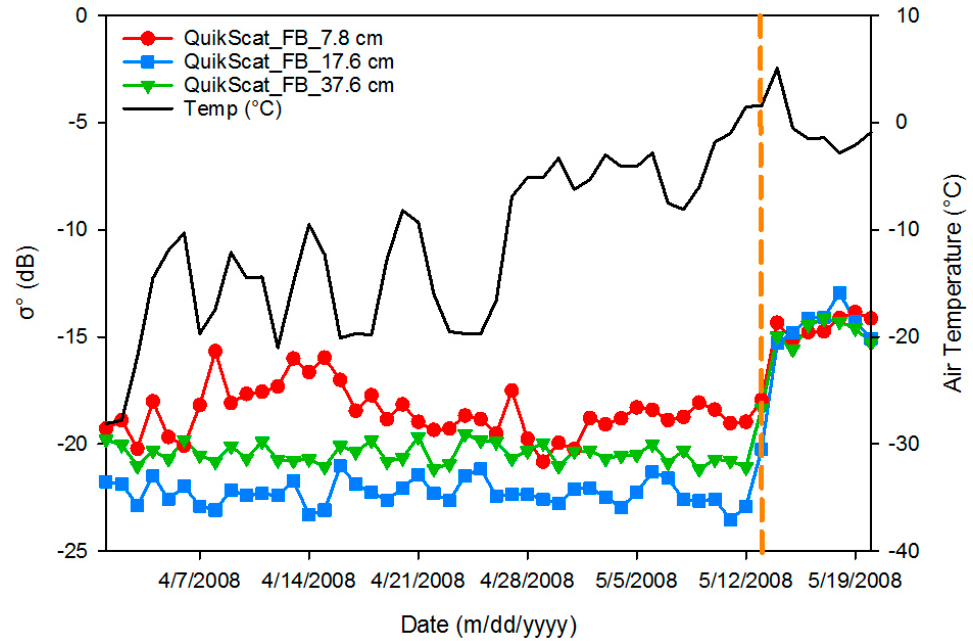
Figure 4. Time series evolution of daily mean air temperature and QuikSCAT σ ° for the Franklin Bay (FB) snow thickness sites between April 1 and May 20, 2008 (during the winter season). The upturn in σ ° at melt onset on ~ May 13 for each of the snow thickness sites is denoted by the vertical dashed line.